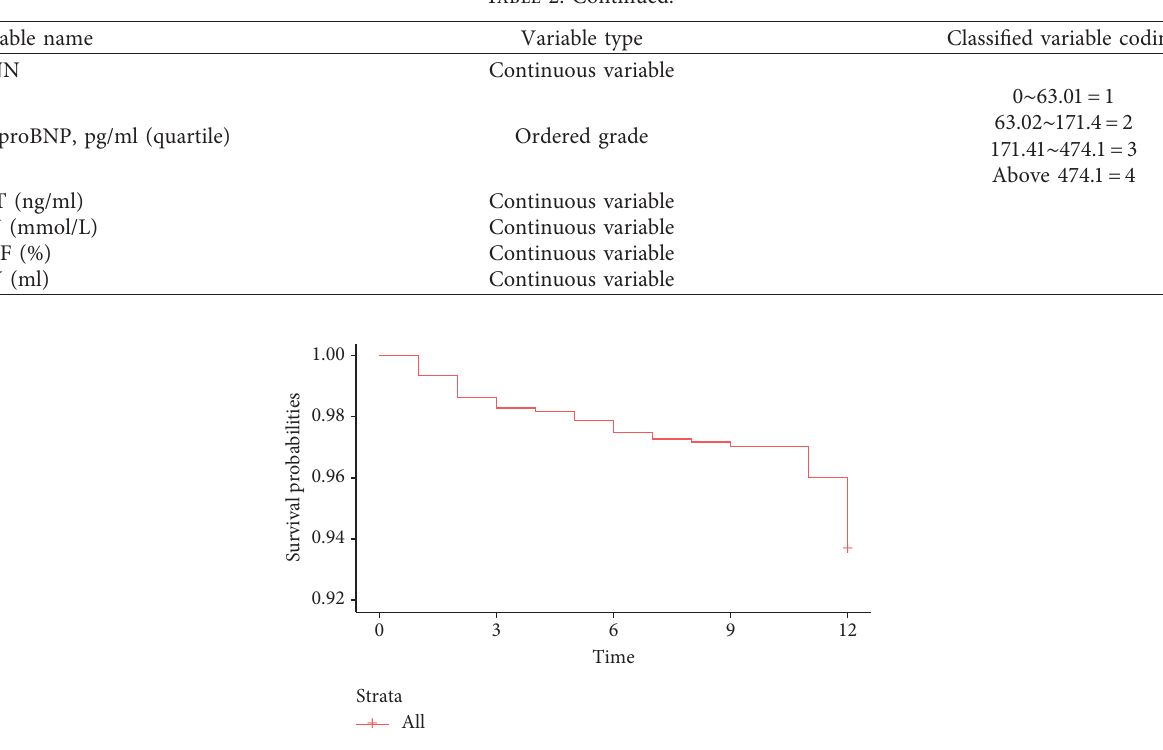
Figure 1: The cumulative survival rate of all patients in 12 months. Table 3: Multivariate analysis of model group by Cox regression.